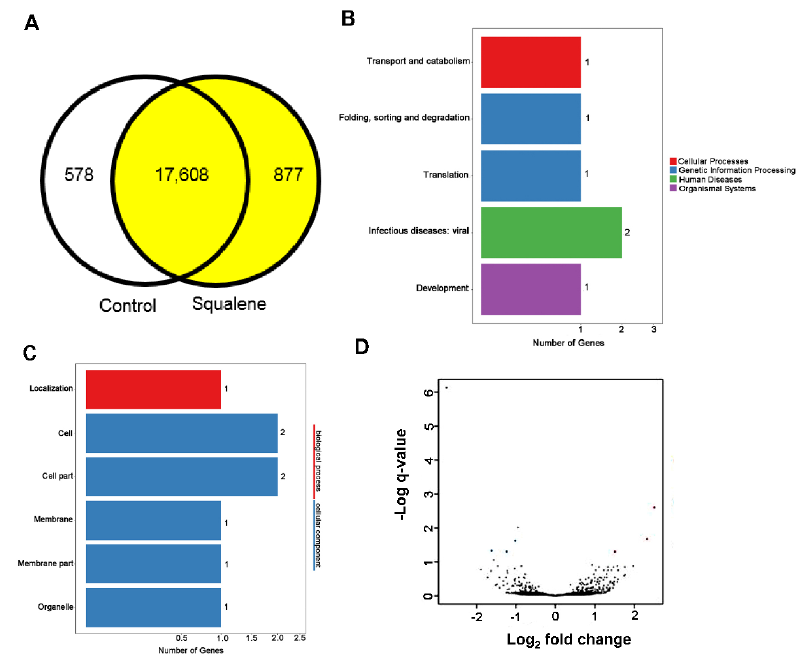
Figure 4. Differentially expressed genes ( A ) Venn diagram analysis. Control expressed 18,186 transcripts vs. 18,485 in squalene group. ( B ) Pathway classification of DEGs, X axis; number of DEG. Y axis; functional classification of KEGG. ( C ) GO classification of DEGs, axis represents number of DEG. Y axis represents GO term. ( D ) Volcano plot of DEGs. X axis, log 2 transformed fold change. Y axis; -log 10 of false discovery rate. Table 1. Hepatic transcripts differentially downregulated by the administration of squalene at the level of signal log 2 ratio < 1.5 and false discovery rate < 0.001 in male Oryctolagus cuniculus according to RNAseq.